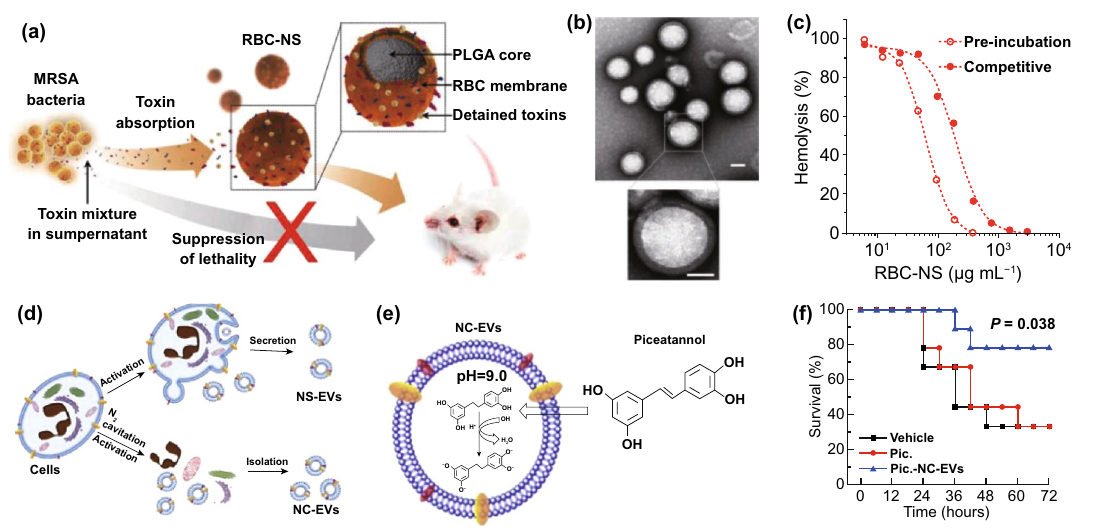
Fig. 17 Biomimetic nanosponges coated with RBC-derived membranes protect against sepsis induced by bacterial wSP. a Schematic illustra- tion of using RBC-NS to treat MRSA toxin-induced septic shock. b TEM images of RBC-NS. c Dose-dependent wSP neutralization by RBC-NS against hemolysis. Neutralization was performed in both preincubation and competitive regimens. Reproduced with permission from Ref. [238]. Copyright 2019 John Wiley and Sons, Inc. High-yield neutrophil-derived EVs produced by nitrogen cavitation for anti-inflammatory therapy. d Schematic illustration revealing the production of NS-EVs and NC-EVs. e Structure and fabrication of Pic-NC-EVs. f Survival rates of LPS- induced septic mice with different treatments including vehicle, Pic, or Pic-NC-EVs. Reproduced with permission Ref. [241]. Copyright 2017